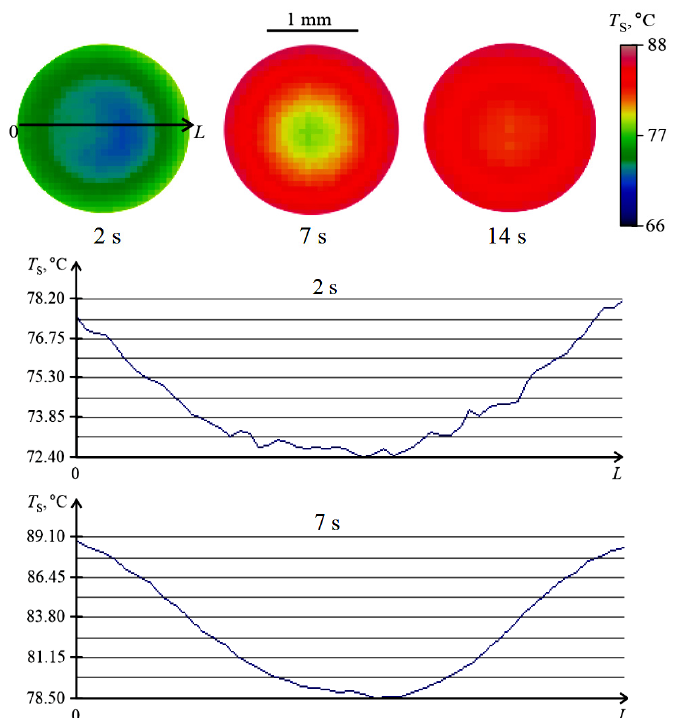
Figure 11. Thermal images of the water droplet interface and temperature profiles of the droplet interface at the cross section of 0 L ( T w = 90 °C).